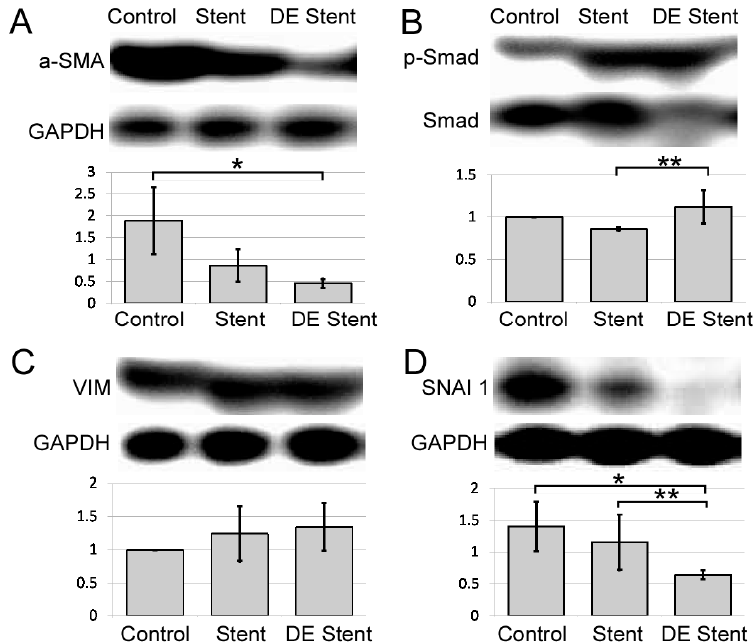
Figure 6. Semi-quantification of epithelial–mesenchymal transition and TGF- β signaling proteins by Western blot analysis. ( A ). α -SMA expression over GAPDH, ( B ). Phosphorylated Smad over total Smad, ( C ). Vimentin over GAPDH, ( D ). SNAI1 over GAPDH. * p < 0.05 represents a significant difference for the DE stent group compared with the control stent group. ** p < 0.05 represents a significant difference for the DE stent group compared with the NDE stent group.